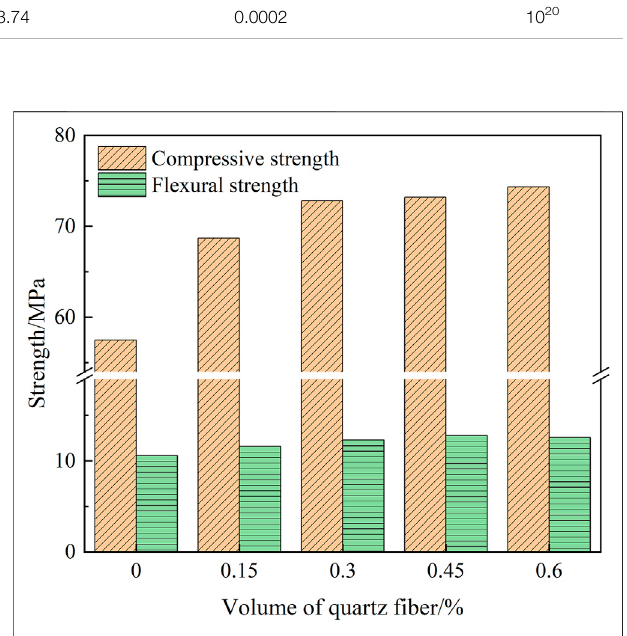
FIGURE 2 | Compressive strength and fl exural strength of high-alumina cement of different fi ber content.